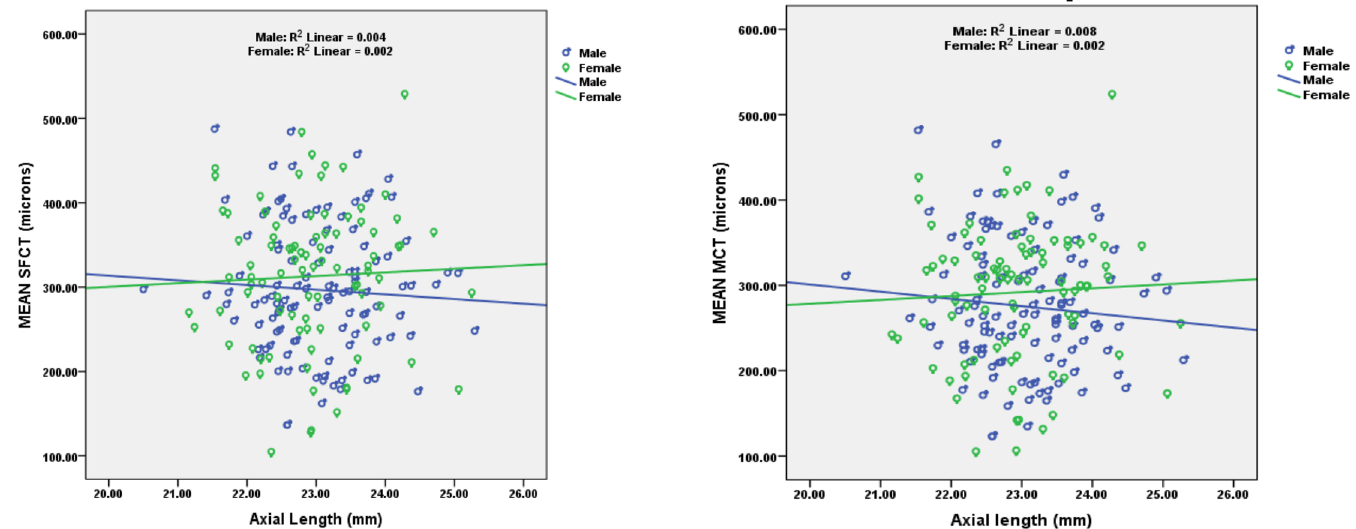
Fig 6. Scatter plot showing correlation between axial length, and subfoveal choroidal thickness (left) and mean choroidal thickness (right).